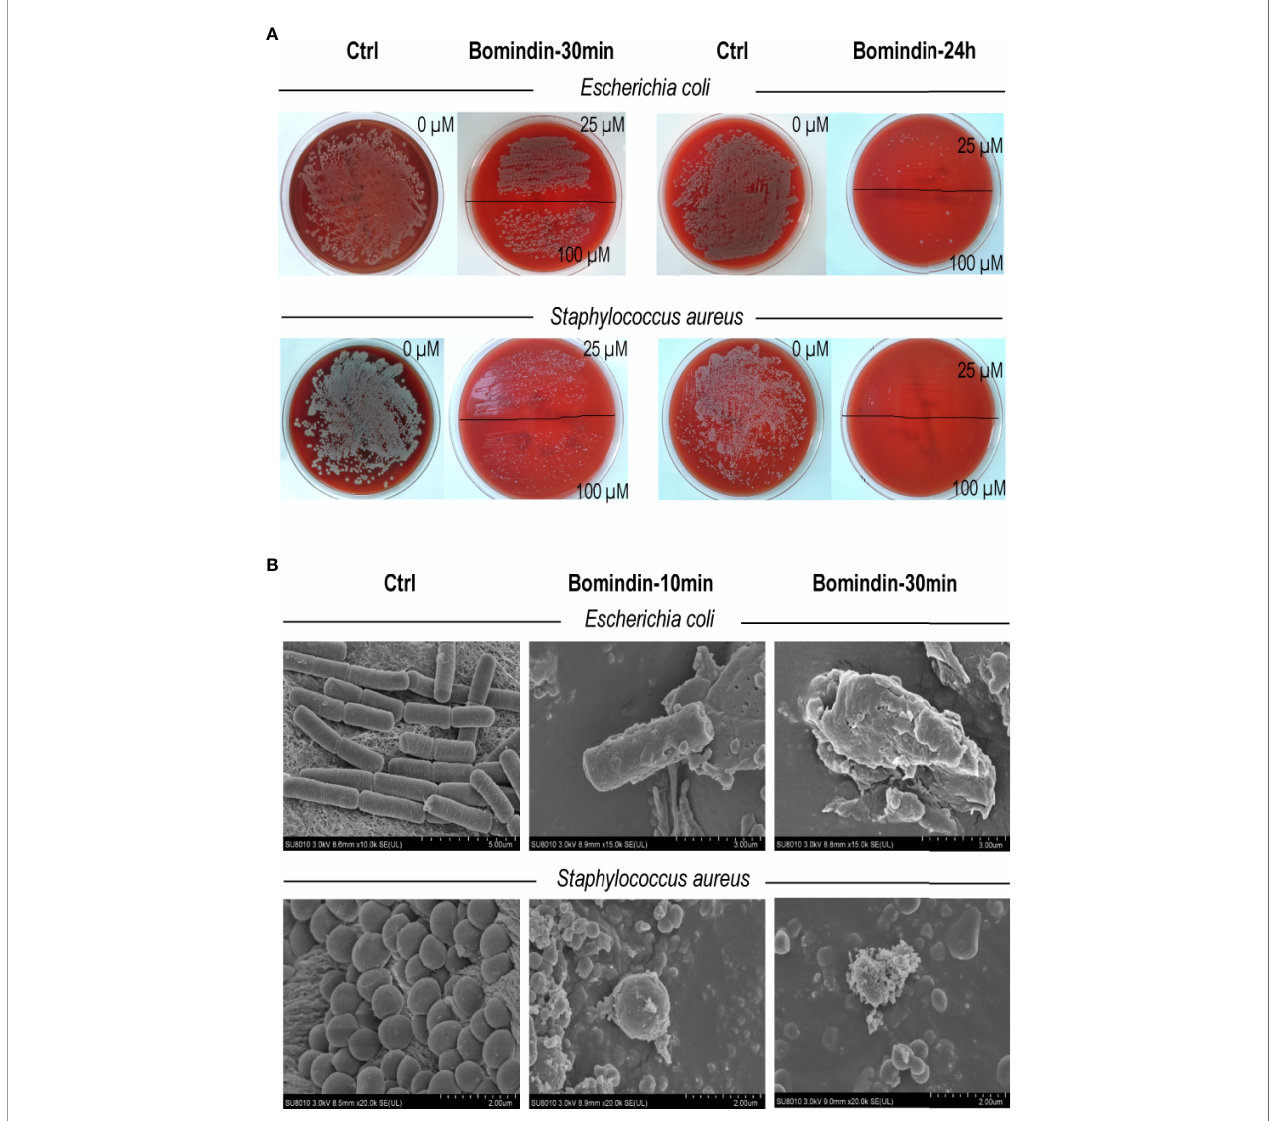
FIGURE 2 | Assessment of bomidin as an inhibitor of bacterial growth. (A) The 25 m M and 100 m M doses of bomidin treatment signi fi cantly reduced bacterial populations within 30 min while abolishing the growth of ESBL-producing Escherichia coli and Staphylococcus aureus within 24 h. (B) After 30 min or 1 h of bomidin treatment, the number and size of bacteria ( B. subtilis, E coli , and S. aureus ) decreased. Perforations, vesicular structures, and some fl occulent material aggregates were observed on the membranes, and some bacteria ruptured into fragmented, unclear